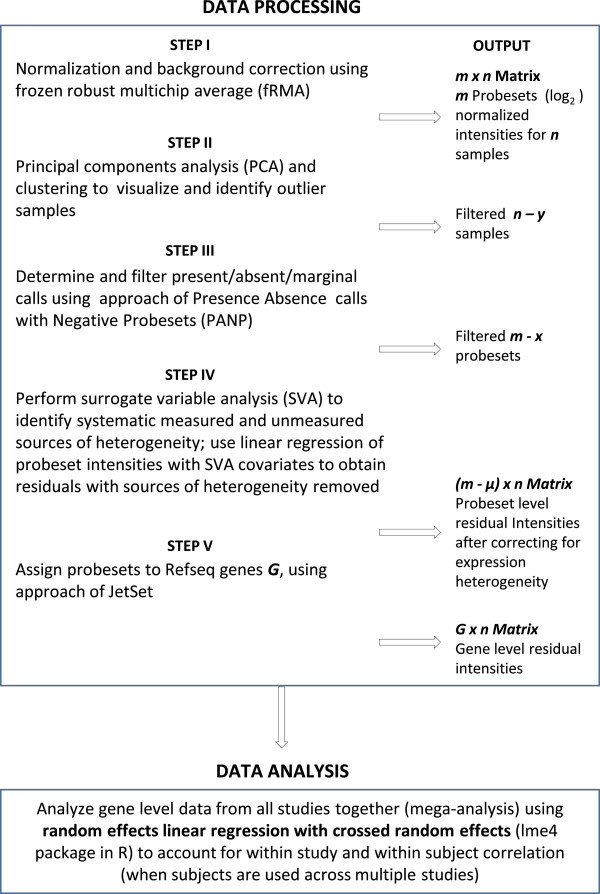
Workflow for data processing and analysis.